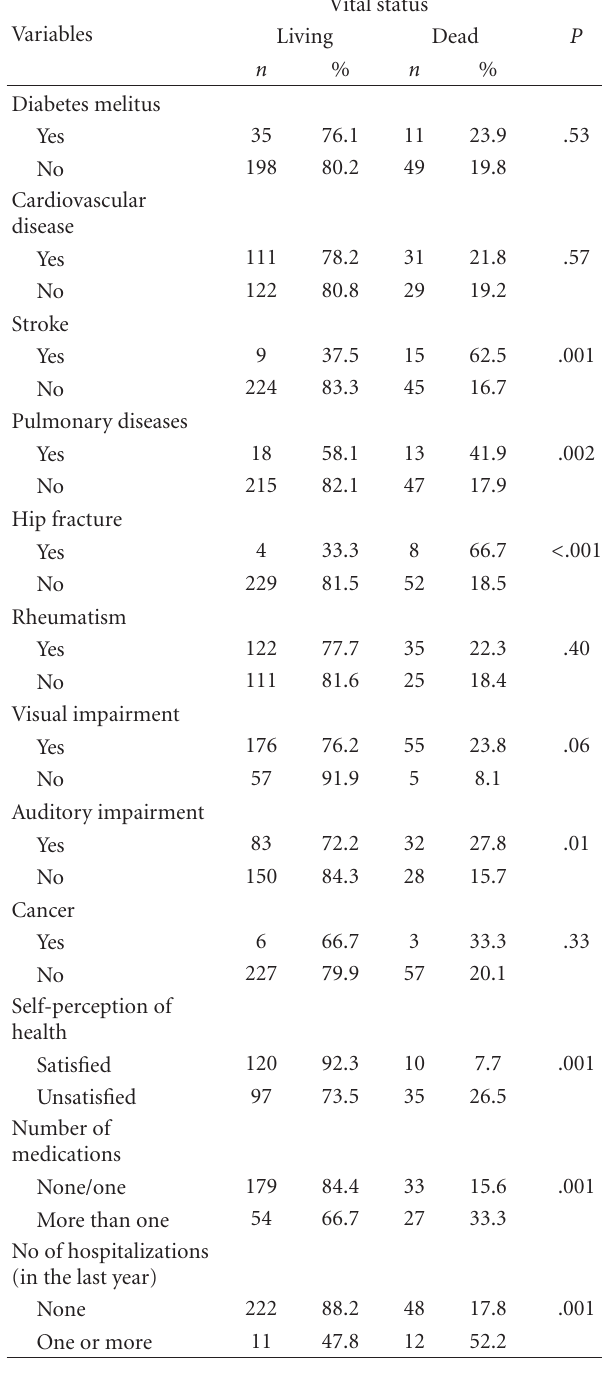
Table 1: Distribution of vital status, according to sociodemo- graphic variables of elderly residents in Santa Cruz, Brazil.